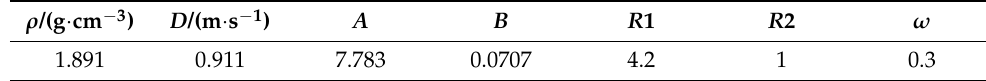
Table 1. Explosive Material Parameters.